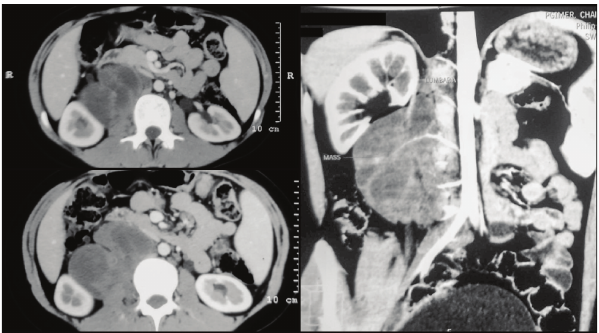
Figure 1: Axial and coronal sections on CECT abdomen and pelvis showing the extent of the